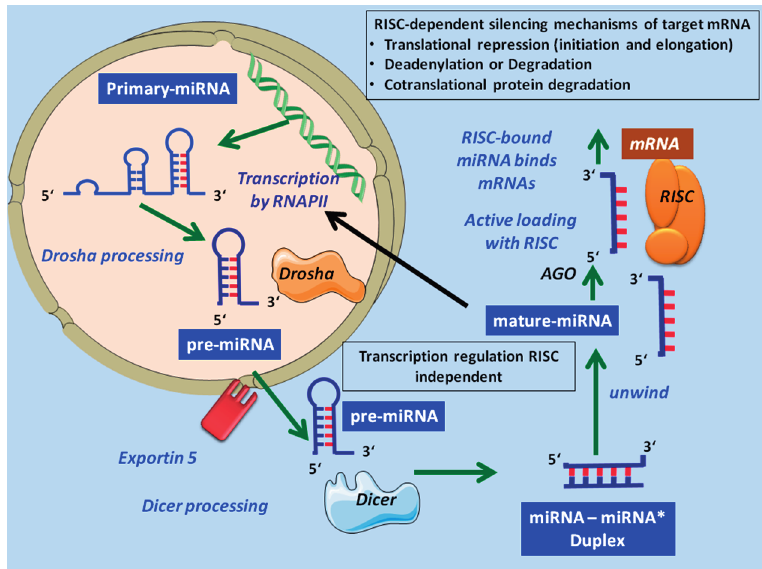
Figure 1. Canonical biogenesis pathways of microRNAs. RISC, RNA Interfering silencing